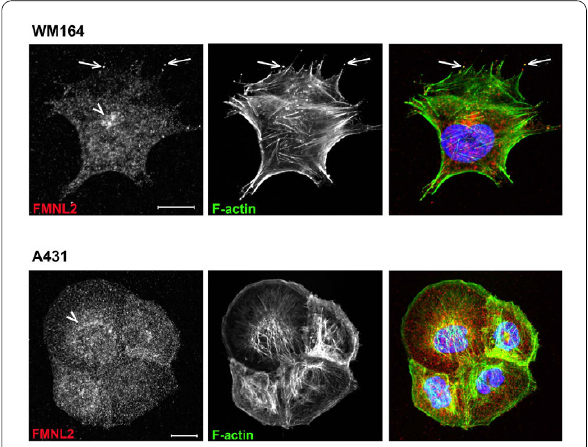
Figure 4 Confocal microscopic analysis of FMNL2 in WM164 mel- anoma cells and A431 squamous cell carcinoma cells . FMNL2 (left, red) was visualized with antibody, F-actin (middle, green) with phalloi- din, the nucleus with DAPI (blue) and the cells analyzed with a confocal microsope. Top row: In WM164 cells, FMNL2 is located both diffusely in the cytoplasm and perinuclearly (blue) consistent with the location of the Golgi apparatus (arrowhead). WM164 cells have prominent protru- sions with long actin filaments. At the tips of these protrusions, FMNL2 and F-actin are co-localized (arrows). Bottom row: A431 cells lack pro- trusions. FMNL2 is seen in the cytoplasm, faintly concentrated to the perinuclear location (arrowhead). No co-localization with F-actin is ev- ident. Bar = 20